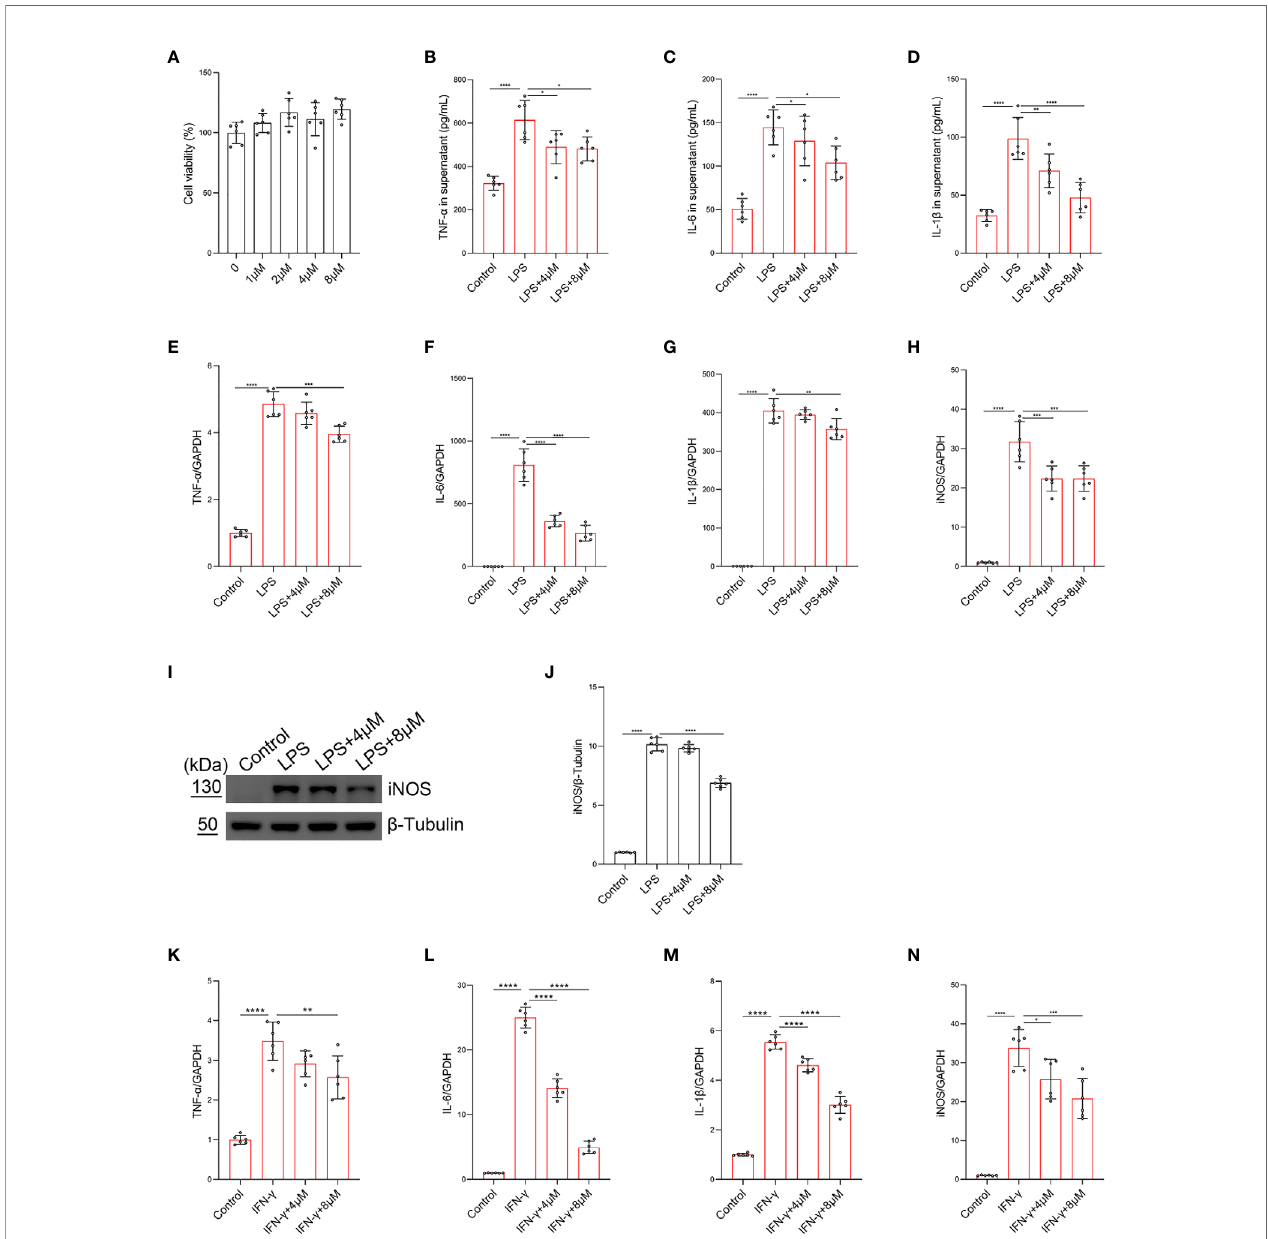
FIGURE 4 | Butorphanol inhibited M1 macrophage activation. Macrophages were collected and cultured from the bone marrow of mice and treated with different concentrations of butorphanol (0-8 m M) for 24 h. (A) CCK-8 analysis of cell viability. Cells were incubated with LPS (1 m g·mL -1 ) alone or butorphanol (4 m M or 8 m M) plus LPS (1 m g·mL -1 ) for 24 h. (B – D) TNF- a , IL-6, and IL-1 b protein levels in the supernatant of macrophage cultures were determined by ELISA. (E – H) The mRNA expression of proin fl ammatory cytokines (TNF- a , IL-6, IL-1 b , and iNOS) in cells was measured by qRT-PCR. (I) The levels of iNOS were measured by western blot analysis. (J) Densitometric analysis of iNOS levels in (I) was performed with normalization to b -tubulin. Cells were incubated with IFN- g (100 ng·mL -1 ) alone or butorphanol (4 m M or 8 m M) plus IFN- g (100 ng·mL -1 ) for 24 h. (K – N) The mRNA expression of proin fl ammatory cytokines (TNF- a , IL-6, IL-1 b , and iNOS) in cells was measured by qRT-PCR. The results are the means ± SEM of six independent experiments. Statistical analysis was performed by one-way ANOVA followed by Tukey ’ s post hoc test when comparing multiple independent groups. *P < 0.05, **P < 0.01, ***P < 0.001, ****P <